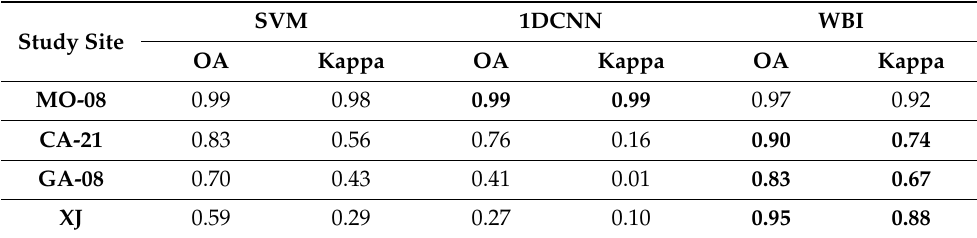
Table 4. Accuracy of cotton classification based WBI, support vector machine (SVM), and one- dimensional convolutional neural network (1DCNN).